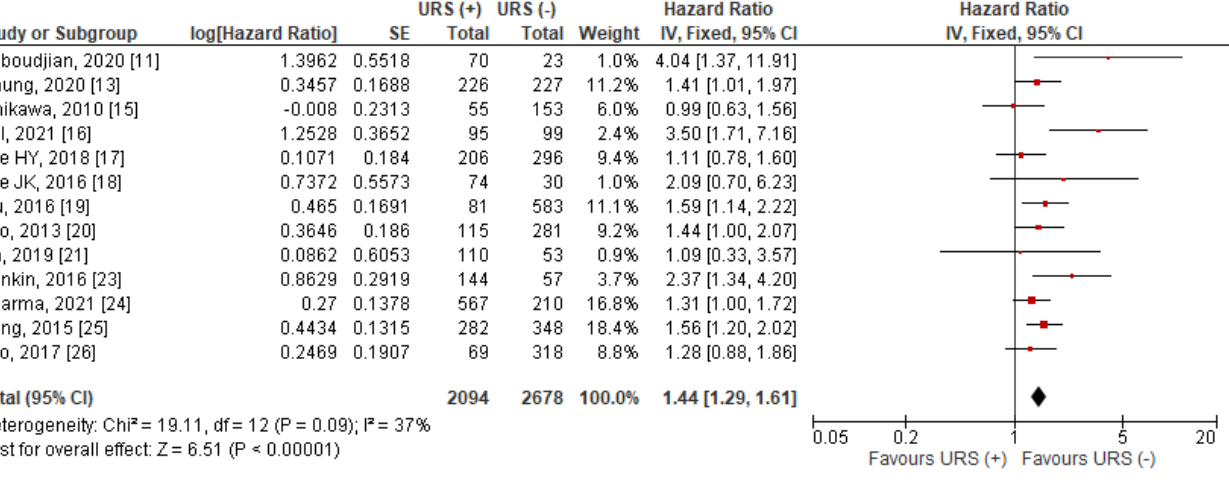
Figure 3. Forest plot and meta-analysis of intravesical recurrence-free surical (IVRFS) [11,13,15–26]. CI = confidence interval; IV = inverse variance; SE = standard error; URS = ureteroscopy.